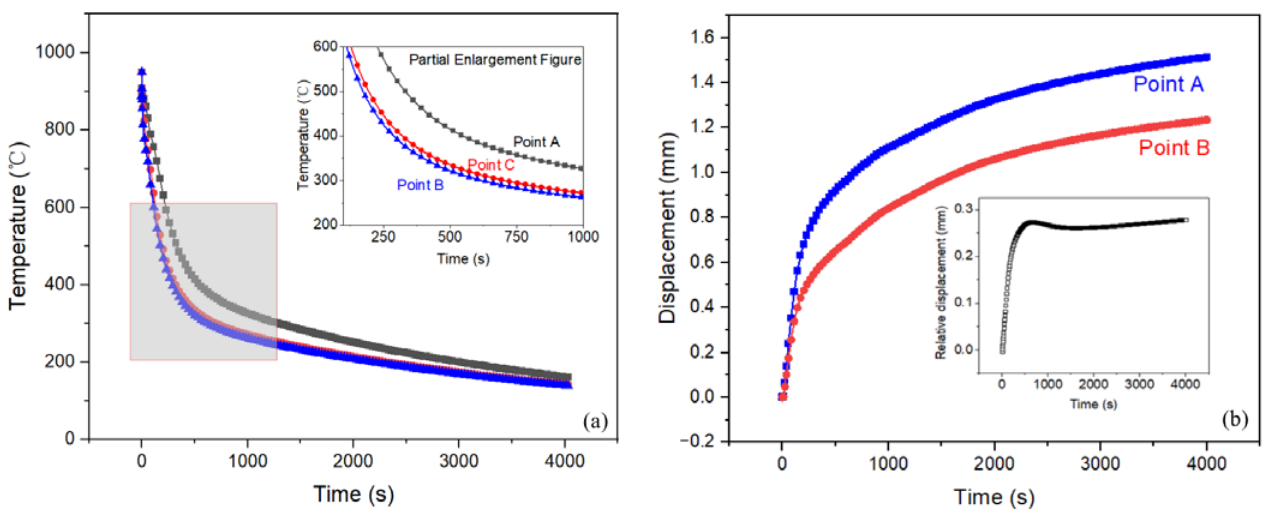
Figure 15. The evolution of selected points by FEM analysis: ( a ) temperature at points A–C; ( b ) dis- placement at points A and B.